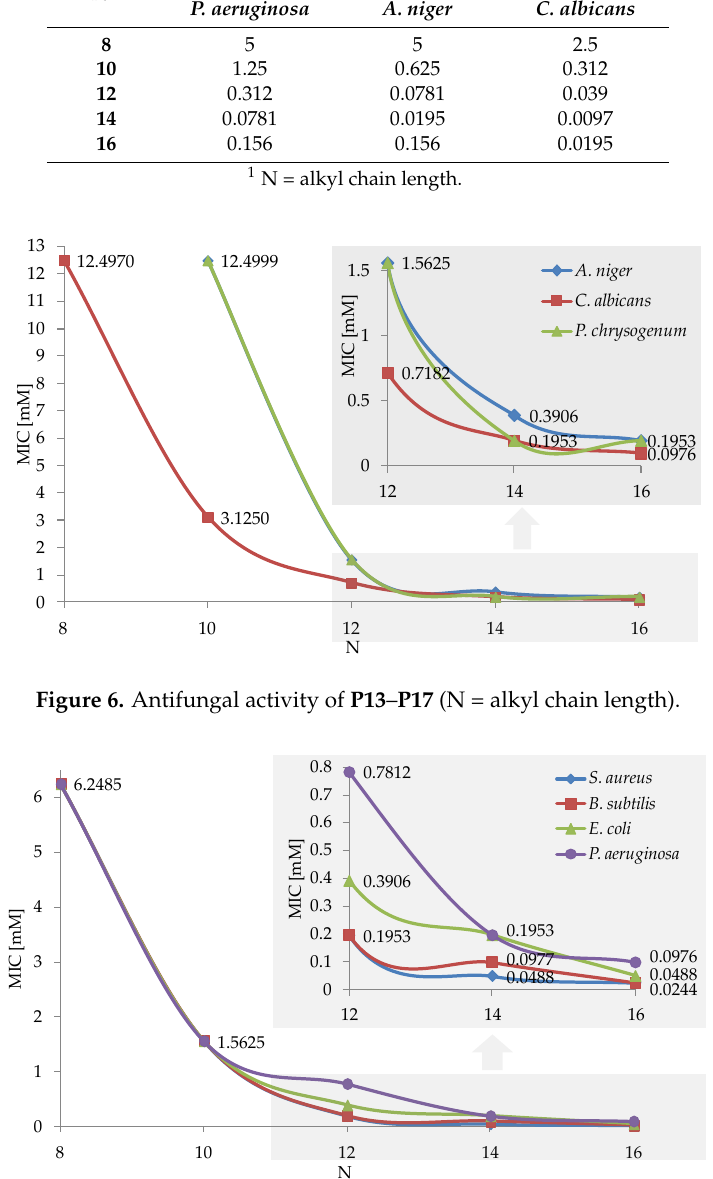
Figure 7. Antibacterial activity of P13 – P17 (N = alkyl chain length).